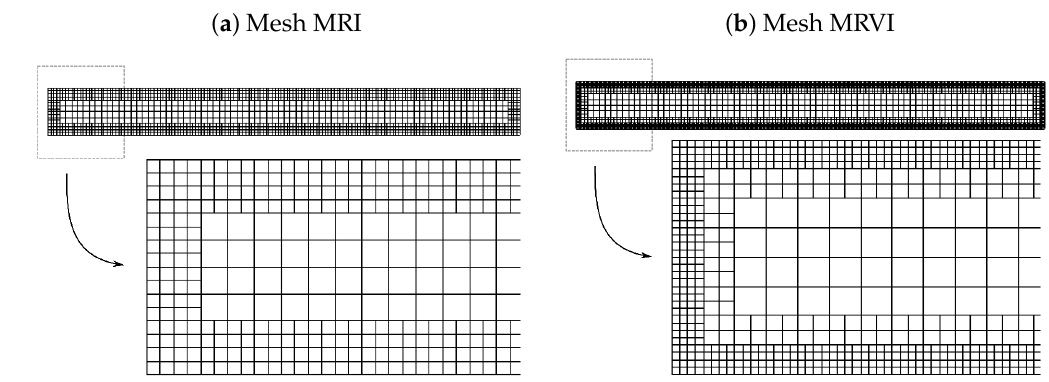
Figure 5. Refined meshes: ( a ) two levels and ( b ) three levels.